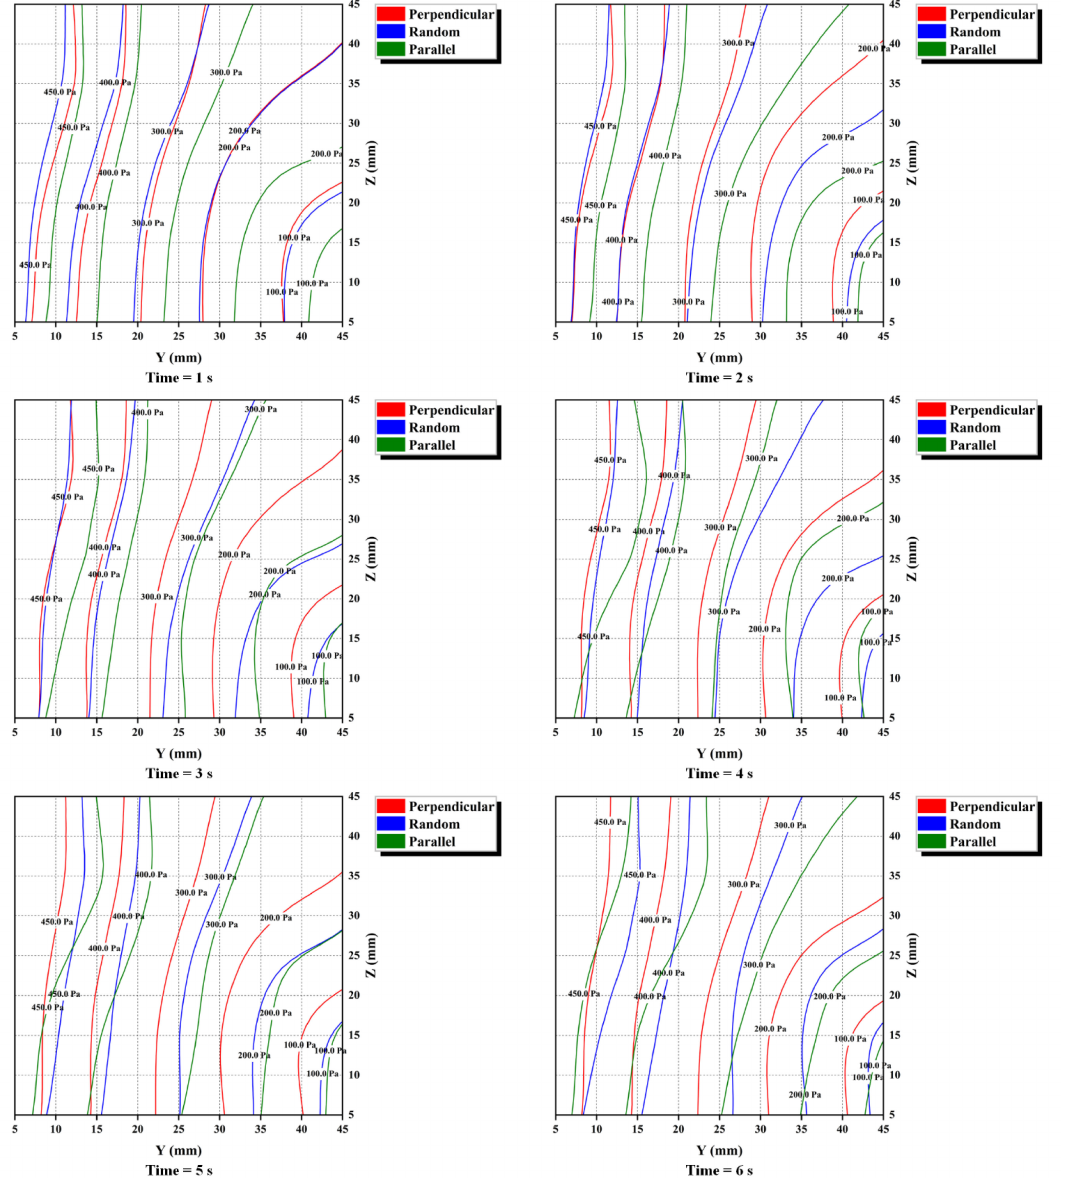
Figure 8. Contour of the evolution of fluid element pressure in the YZ plane with